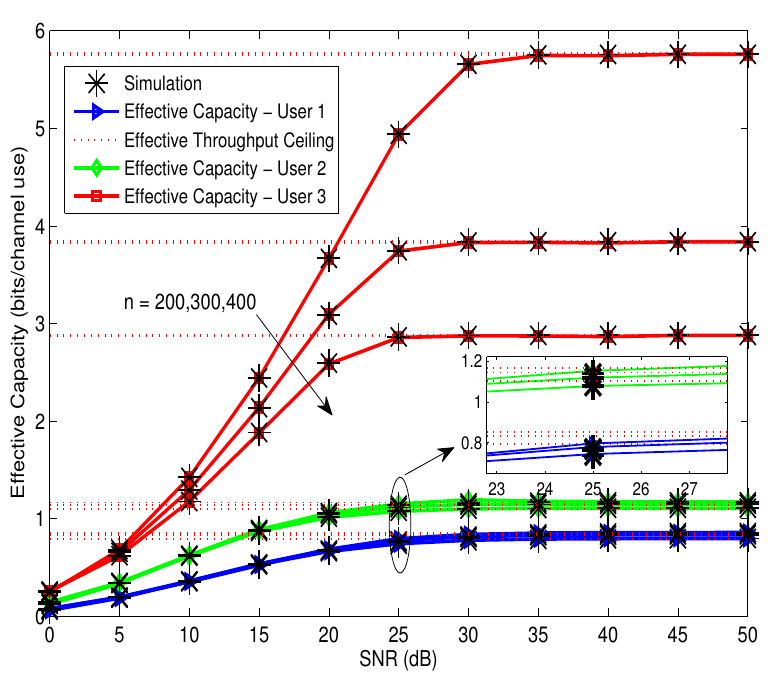
Figure 3. Effective capacity vs. the transmit SNR, with θ 1 = θ 2 = θ 3 = 0.01, and ε = 10 − 5 .